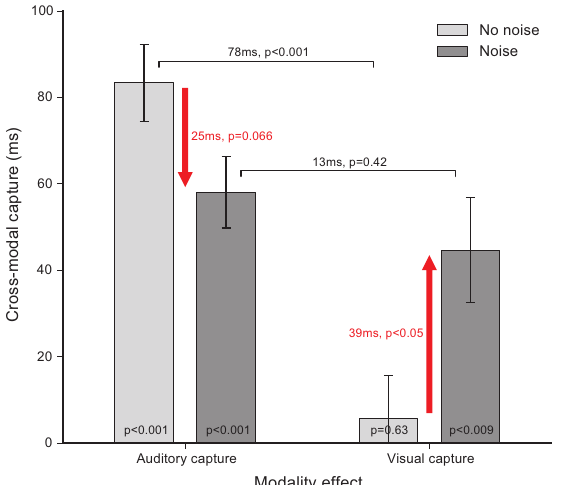
Fig 7. Effect of noise on the sensory attraction. Cross-modalcapture (differencein time shift between +80ms and –80ms SOA) accordingto the capture modality (auditory or visual) and noise condition. No noise conditions were measured in Experiments 1 and 2 (light gray bars) while Noise conditions were measuredin Experiment 4 (dark gray bars). Statistical comparisons were donewith unrelatedStudent’s t-test except for the within comparisonof visual and auditorycapture with noise (Experiment